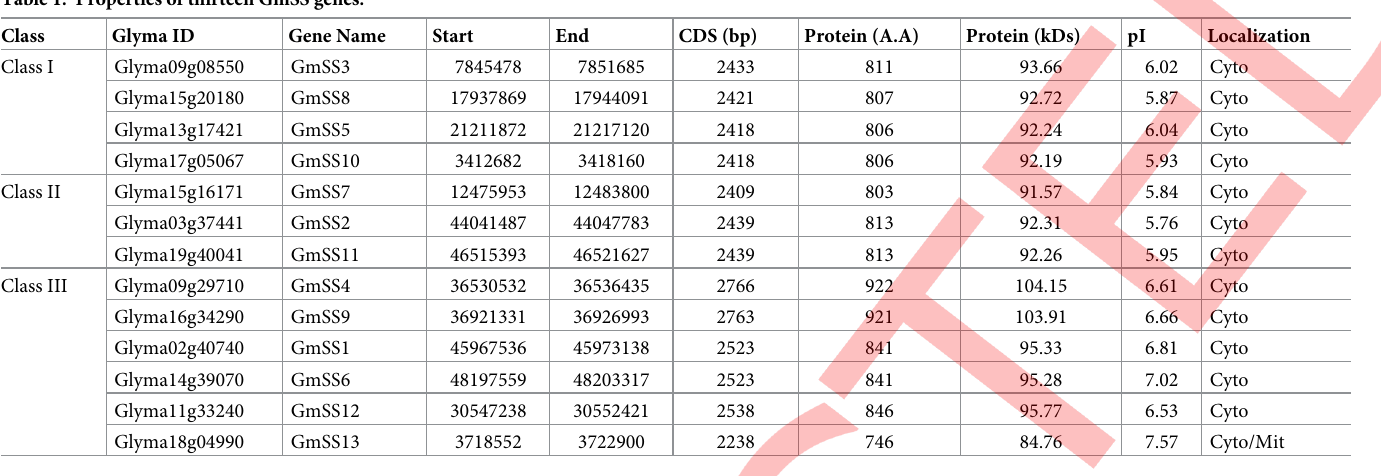
Table 1. Properties of thirteen GmSS genes.